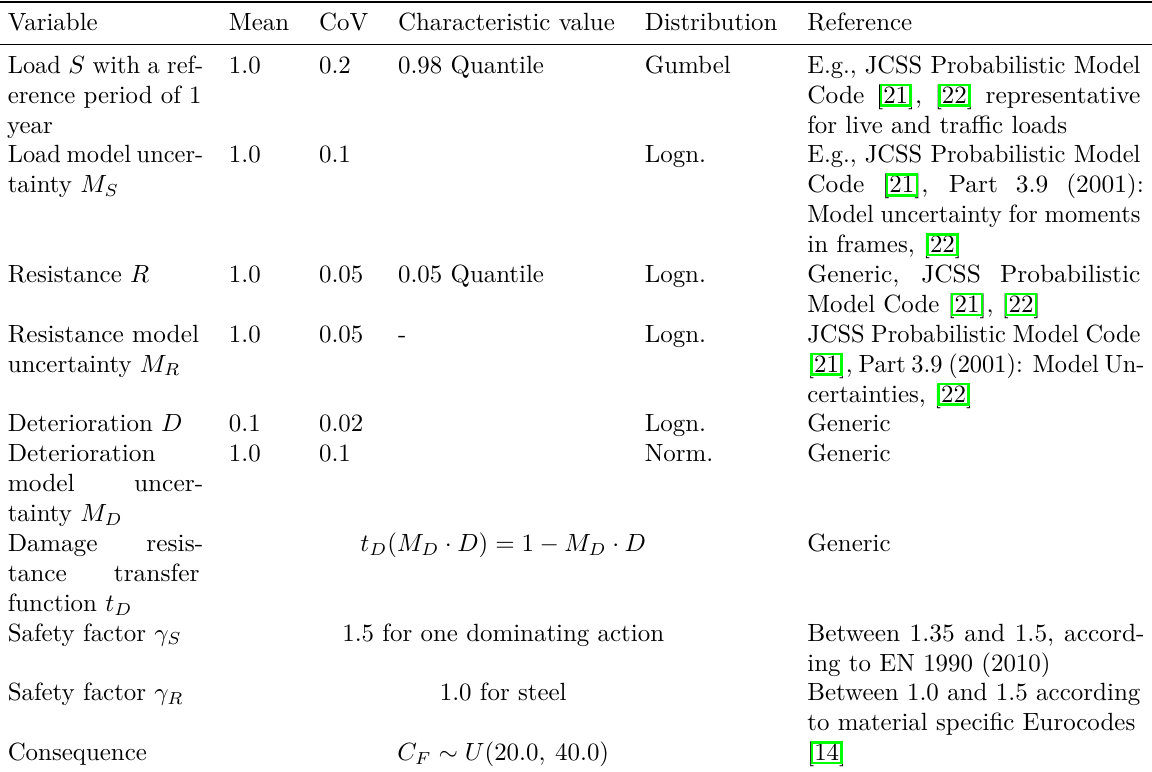
Table 1. Probabilistic system performance